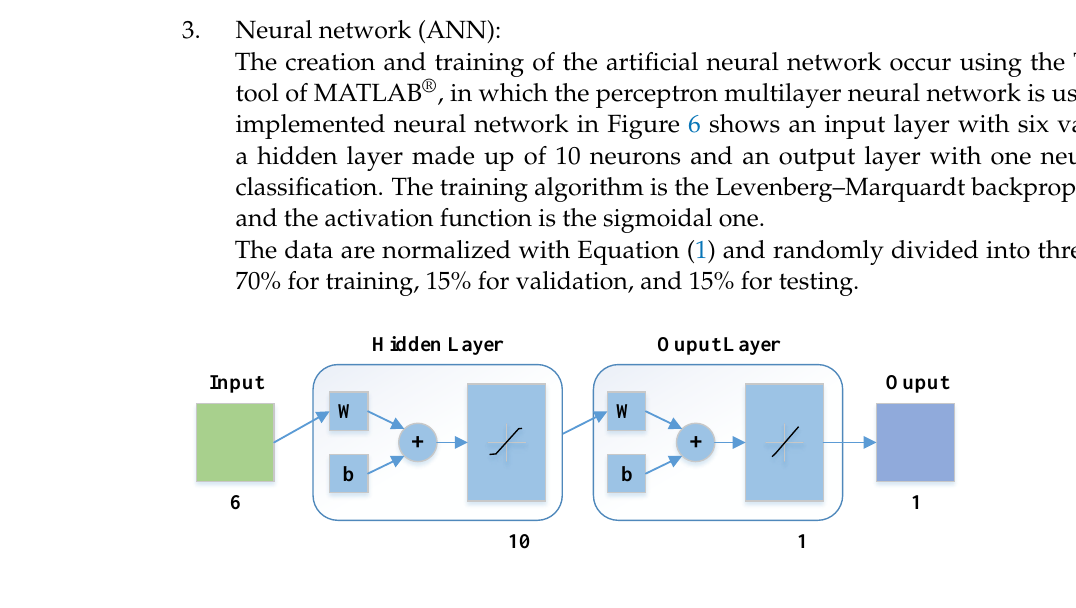
Figure 6. Artificial neural network (ANN).